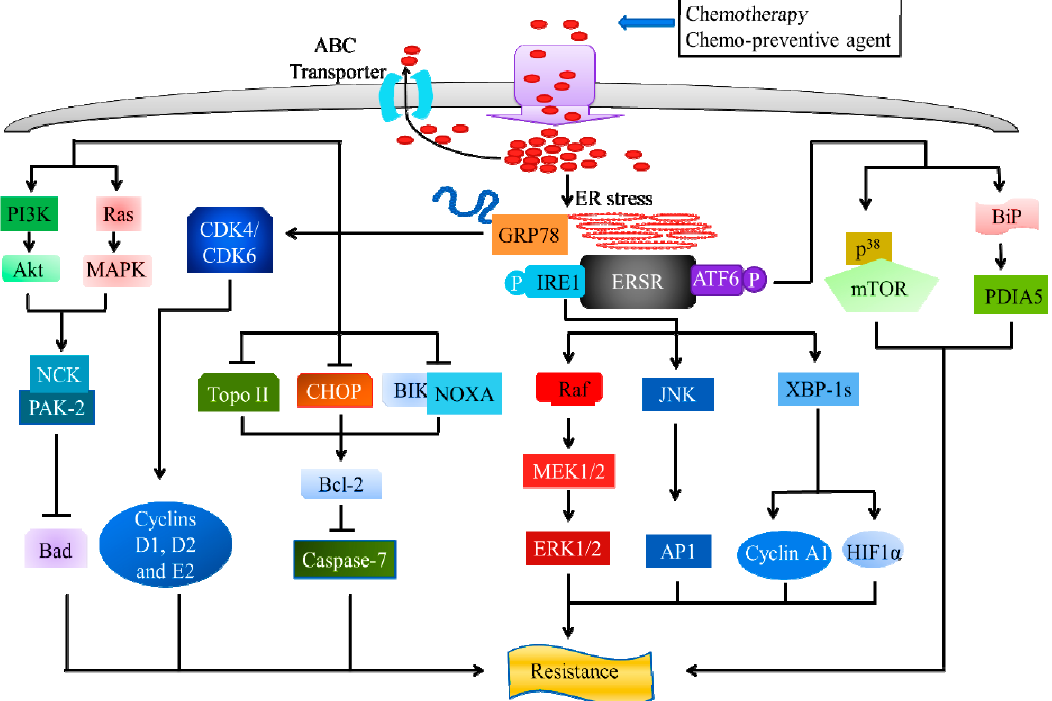
Figure 4. ER stress and chemo-resistance: Role of inositol-requiring enzyme 1 alpha (IRE1), activating transcription factor 6 alpha (ATF6), and glucose-regulated protein 78 (GRP78). Upon ERS, IRE splices and activates the X-box-binding protein 1 (XBP1) that controls cycline A1 expression and regulates HIF1 α targets. The activation of IRE1 leads to the activation of c-Jun N-terminal protein kinase (JNK), followed by inducing AP-1 transcriptional activity. The Raf/MEK/ERK pathway is also involved in IRE1-mediated chemo-resistance. ATF6 α possesses chemo-resistance through the regulation of ER chaperone BiP protein, mediated by the activation of disulfide isomerase A5 (PDIA5) and p38-dependent ATF6 α -mTOR pathway, upon ER stress. GRP78 exhibits its chemo-resistance properties, upon ERS, through the suppression of C/EBP homologous protein (CHOP), Bcl-2-interacting killer (BIK), phorbol-12-myristate-13-acetate-induced protein 1 (PMAIP1) or NOXA, Topo II, and induction of Bcl-2, leading to the activation of caspase-7 dependent apoptosis. GRP78 suppresses G1/S transition-related cyclins (D1, E1, and E2) and cyclin-dependent kinase (CDK4 and CDK6) protein expression. Additionally, the phosphorylation of GRP78 leads to the activation of Ras/MAPK and PI3-kinase downstream signaling, and the recruitment of p21 activated kinases 2 (PAK-2) via NCK, thus, inhibiting the pro-apoptotic protein Bcl-2-associated death (Bad).